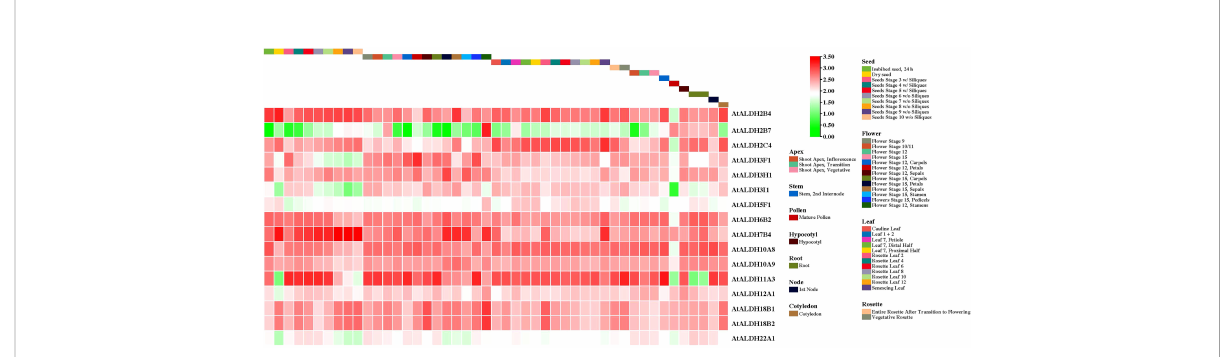
FIGURE 8 The AtALDH gene expression pro fi le during plant growth and development stages of Arabidopsis. The AtALDH gene expression pro fi le was extracted from the Arabidopsis eFP browser (http://bar.utoronto.ca/efp//cgi-bin/efpWeb.cgi ). Regarding growth and development stages of Arabidopsis, the expression pro fi les of 16 AtALDH genes were investigated during different stages of development (seed, fl ower, leaf, rosette, apex, stem, pollen, hypocotyl, root, node, and cotyledon). The scale of fi gure indicates the fold change of AtALDH genes.